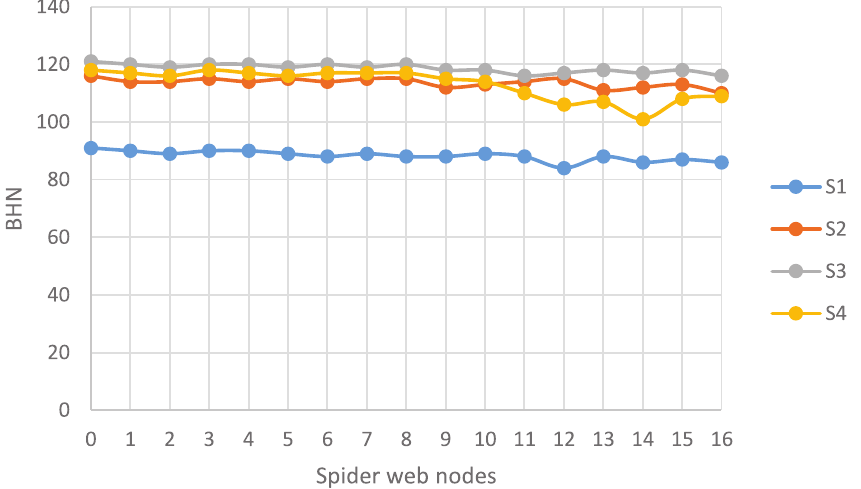
Fig. 11. Variation of hardness at different nodes of the Spider web for